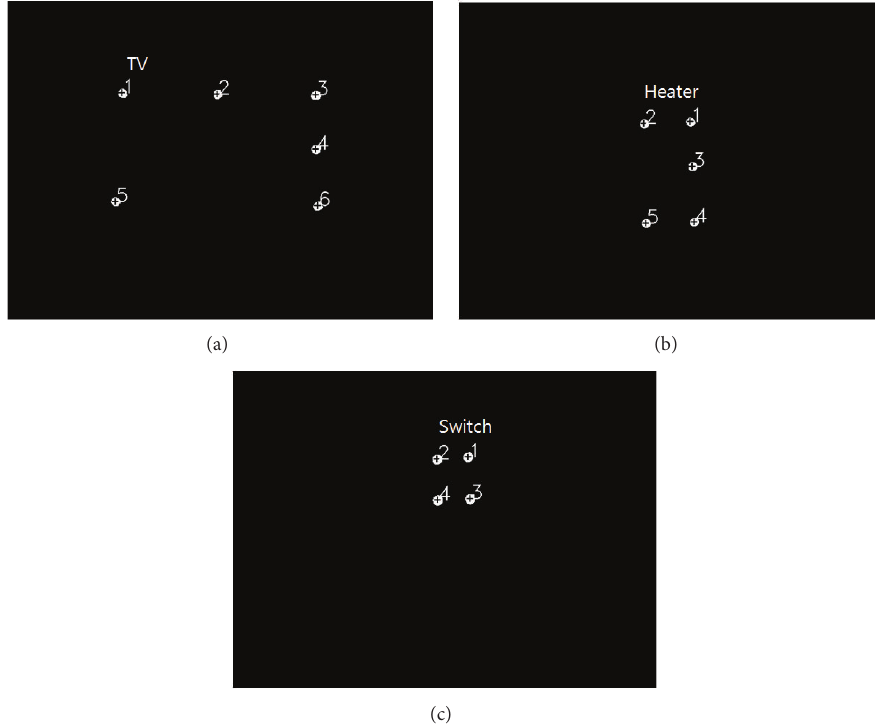
Figure 10: Results of recognition of home appliance in (a) Figure 9(b) at a 𝑍 -distance of 300 cm, (b) Figure 9(c) at a 𝑍 -distance of 300 cm, and (c) Figure 9(d) at a 𝑍 -distance of 200 cm.